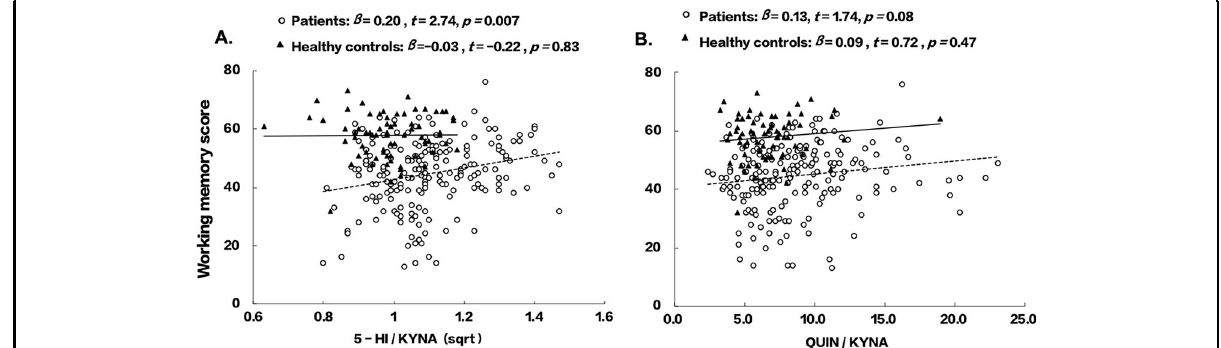
Fig. 2 Relationship between working memory performance and 5-HI/KYNA or QUIN/KYNA. A Relationship of working memory with 5-HI/ KYNA. B Relationship of working memory with QUIN/KYNA.